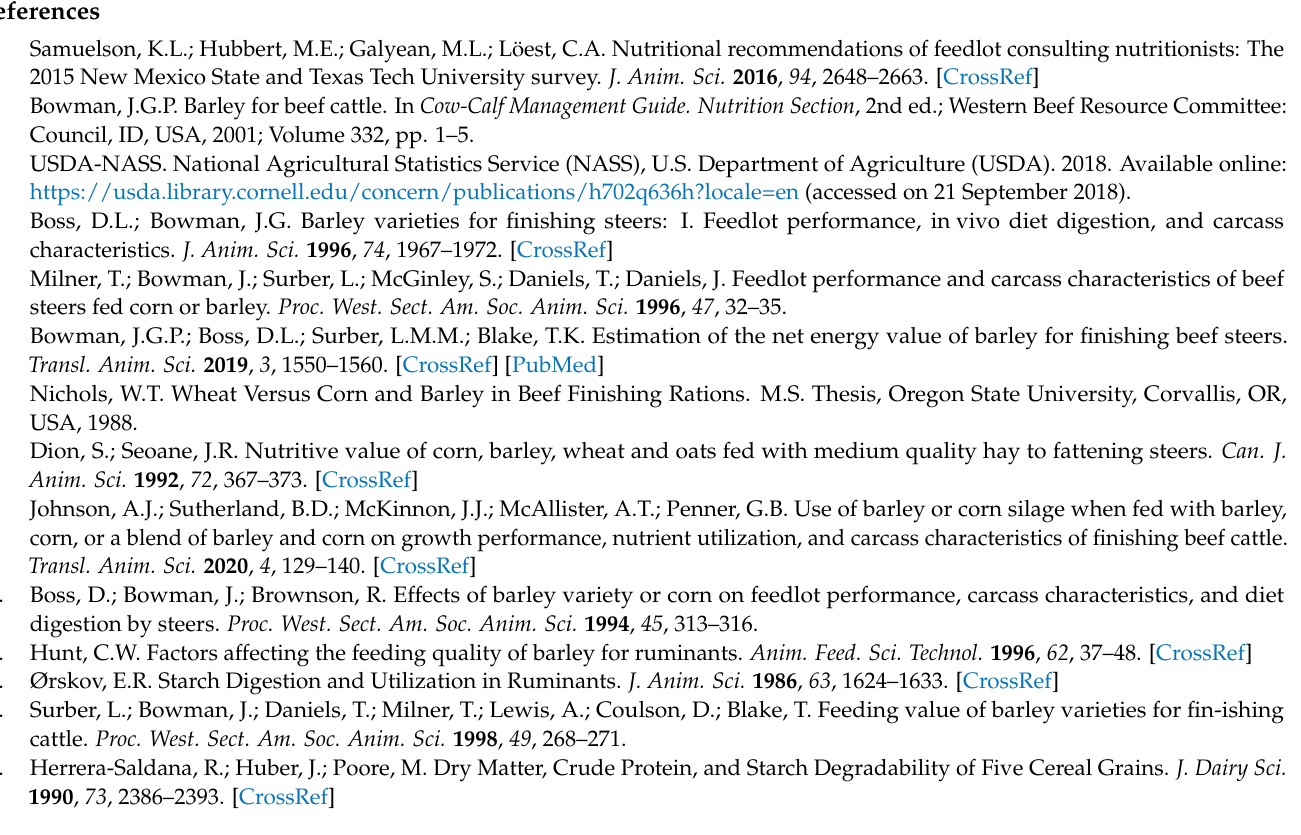
Carcass Data, Table S3: Animal Feeding Behavior Data, Table S4: Animal Performance and Feeding Behavior Data for